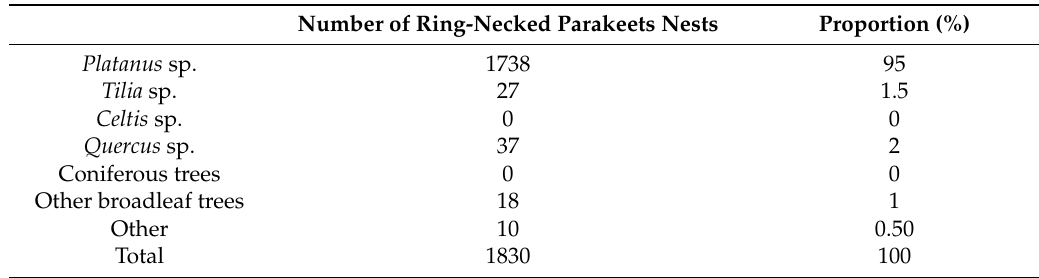
Table 8. Tree species used as nest sites by ring-necked parakeets Psittacula krameri in Marseille, France. Number of Ring-Necked Parakeets Nests Proportion (%) Platanus sp. 1738 95 Tilia sp. 27 1.5 Celtis sp. 0 0 Quercus sp. 37 2 Coniferous trees 0 0 Other broadleaf trees 18 1 Other 10 0.50 Total 1830